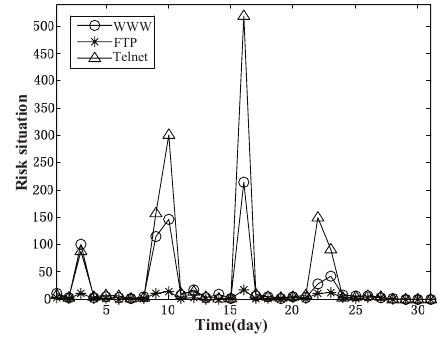
Figure 3: Risk of Services in Real Time